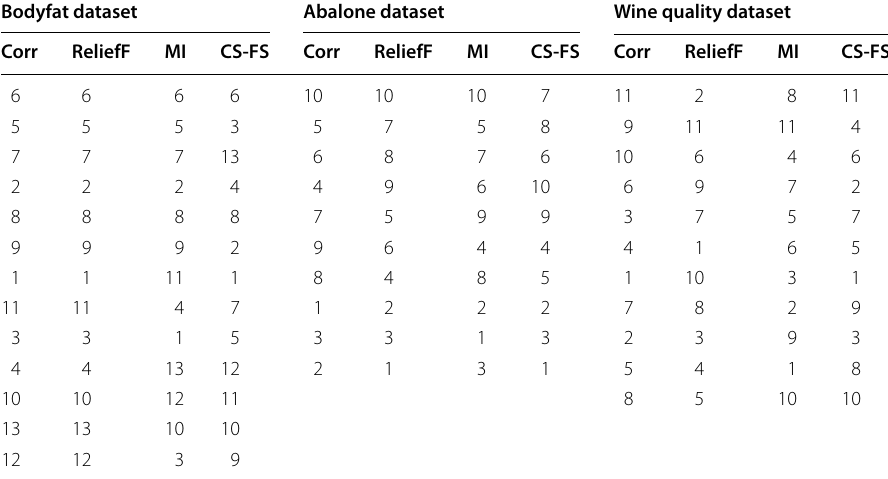
Table 3 Important features identified by various feature selection methods for regression task (ranked in the descending order of their importance) Bodyfat